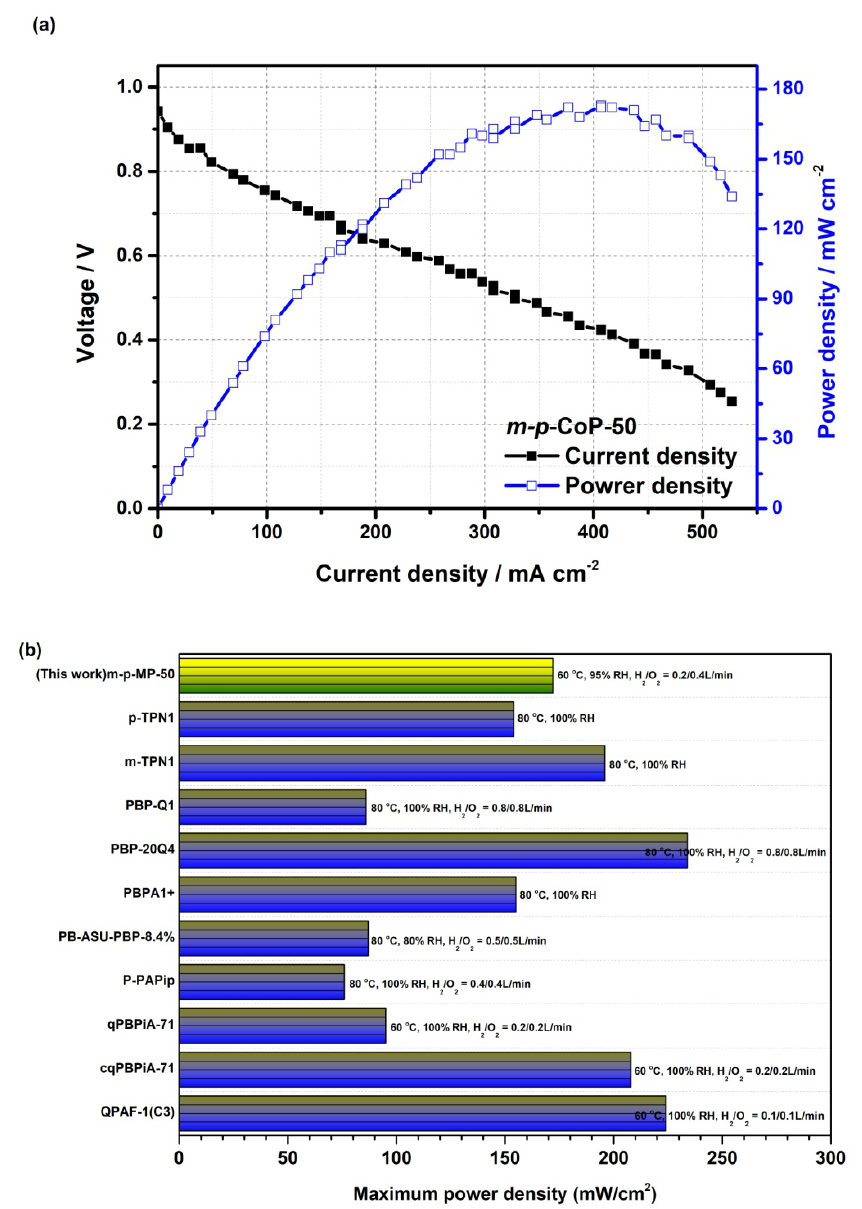
Figure 8. ( a ) H 2 /O 2 single cell performance data of the m-p -MP-50 membrane in 95% RH a t 60 °C and ( b ) maximum power density values of recently reported rigid polymer-based AEMs, compared with the m-p -MP-50